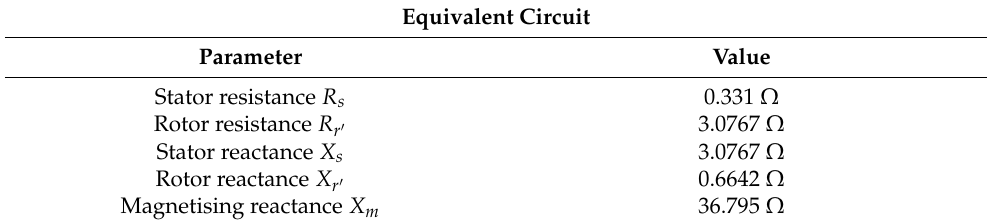
Table 6. Electrical parameters of the three-phase IM.